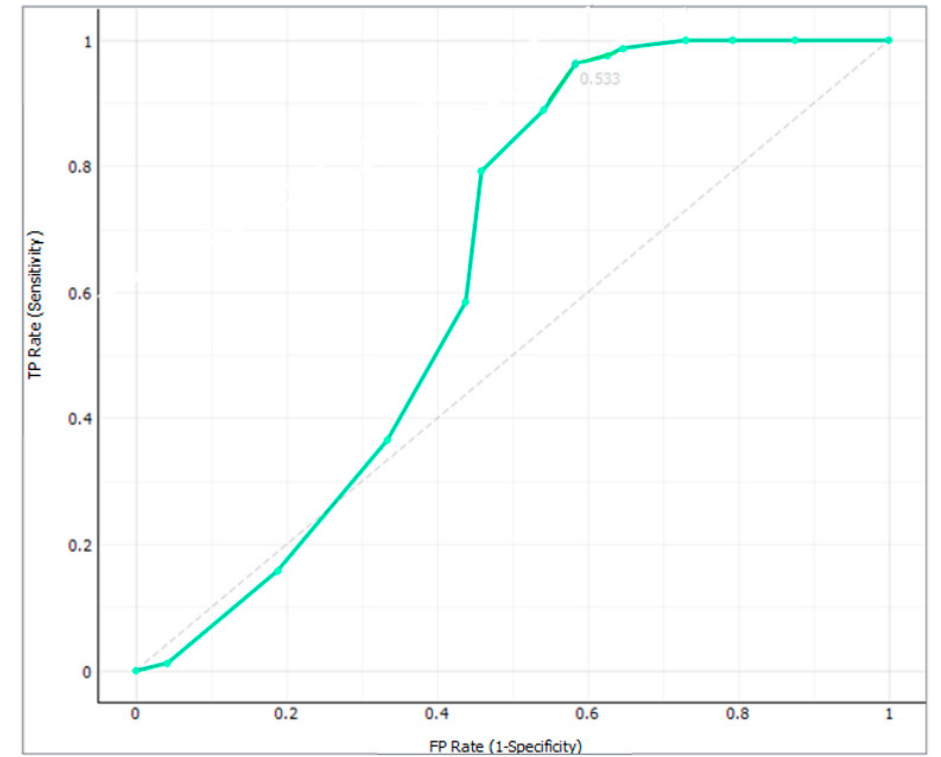
Molecules 2023 , 28 , x FOR PEER REVIEW Figure A1. ROC curve of kNN for the haptoglobin class (-). Figure A1. ROC curve of kNN for the haptoglobin class (-).